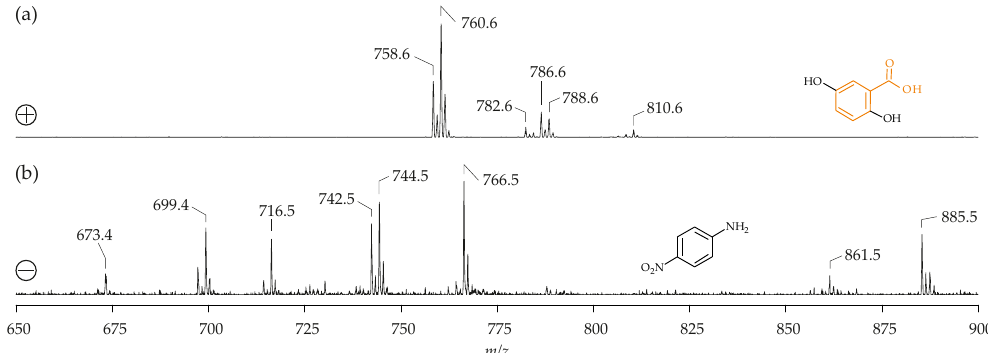
Figure 6. ( a ) MALDI-TOF mass spectrum (positive ionization mode) of an organic hen egg yolk extract recorded in the presence of DHB; ( b ) MALDI-TOF mass spectrum (negative ionization mode) of an organic hen egg yolk extract using 4-nitroaniline (PNA). Both spectra were recorded under exactly the same conditions and in the same solvents. More detailed assignments are available in (reprinted and modified with permission)